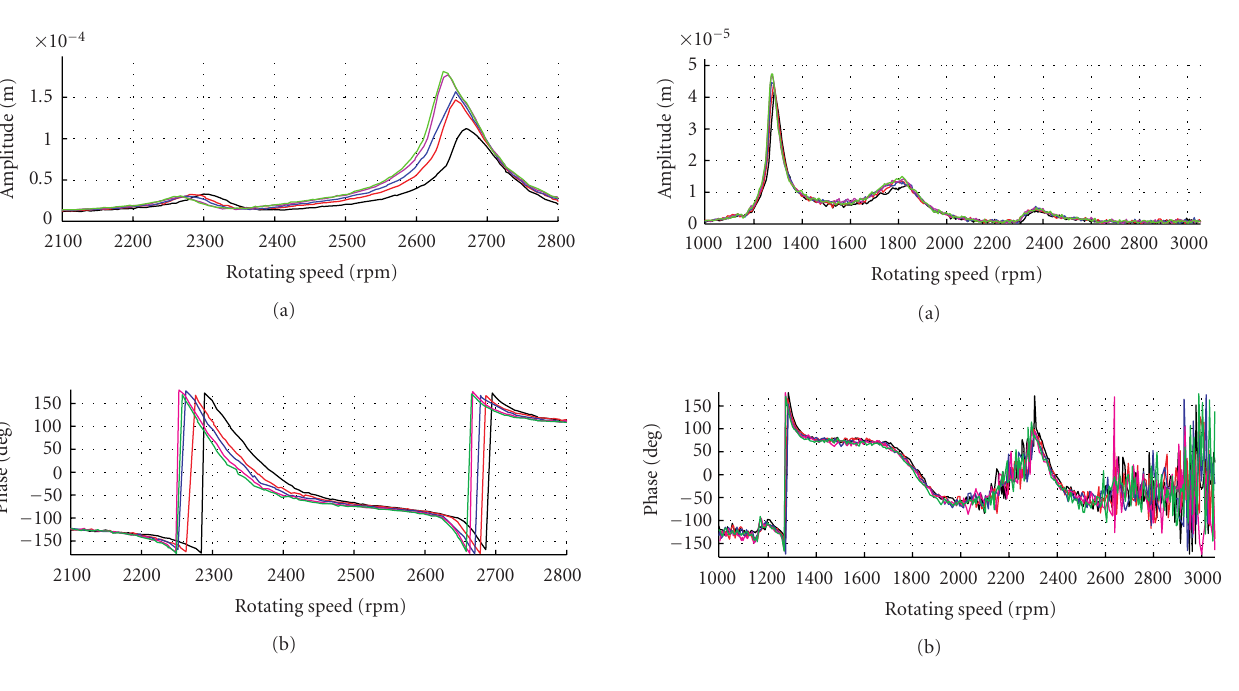
Figure 17: Unbalance responses of the 2nd order during run-down for various bearing temperatures at the bearing support B1 (black line = 33 ◦ C; red line = 36 ◦ C; blue line = 40 ◦ C; magenta line = 42 ◦ C; green line = 44 ◦ C).